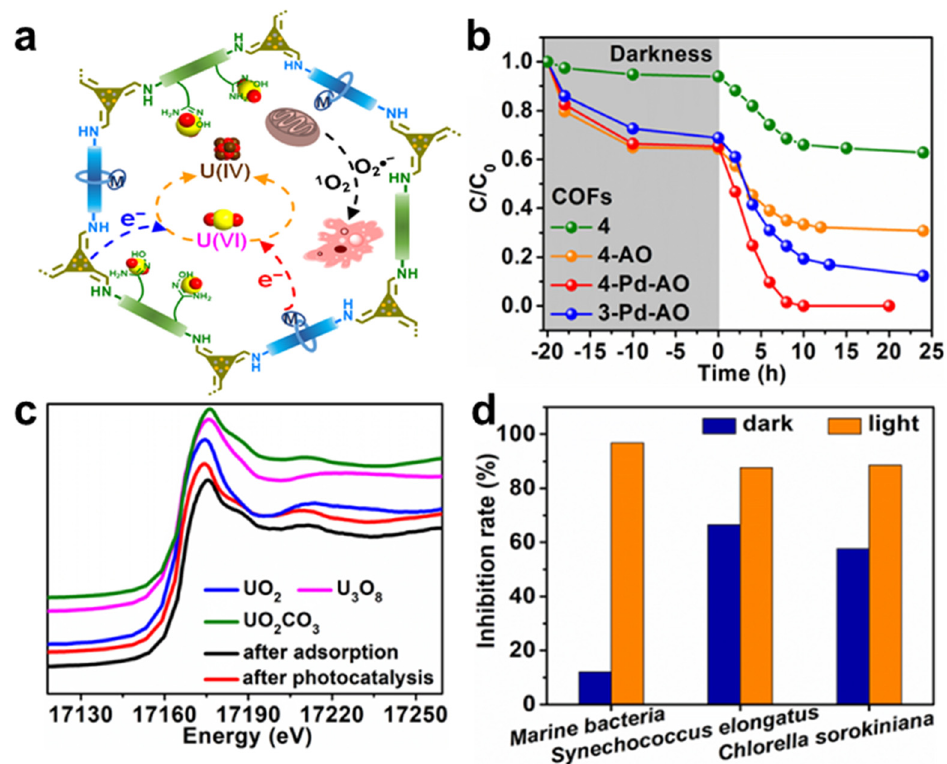
Figure 5. ( a ) Adsorption − photocatalytic strategy for uranium extraction, ( b ) uranium extraction from spiked seawater using adsorbent − photocatalysts, ( c ) U L III -edge XANES spectra for COF 4-Pd-AO after uranium extraction studies, and ( d ) antibiofouling spectrum of COF 4-Pd-AO [45], Copyright 2022 Chinese Chemical Society.